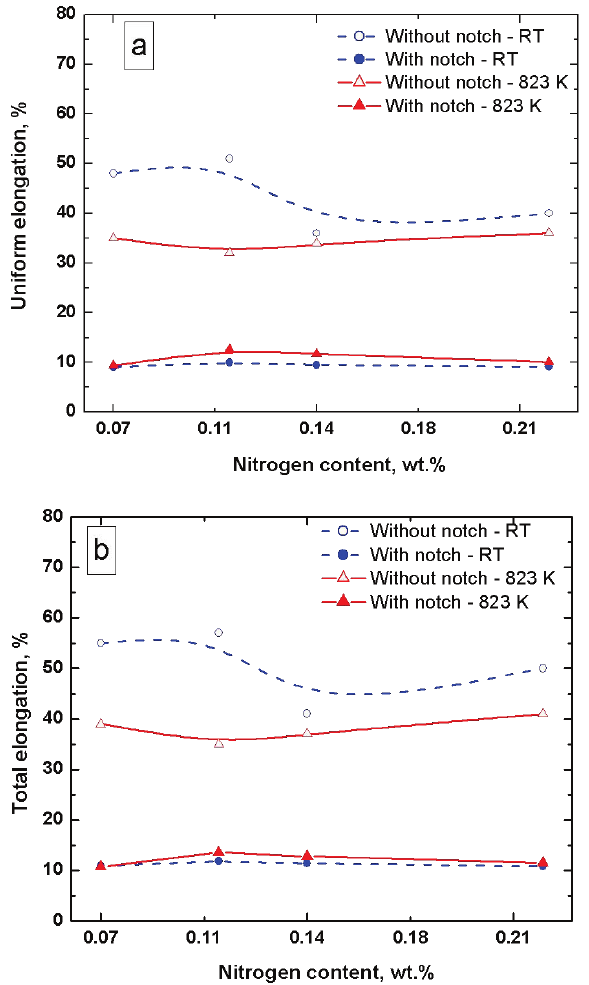
Figure 7. Notch effect on (a) uniform elongation and (b) total elongation, as a function of nitrogen content at room temperature and 823